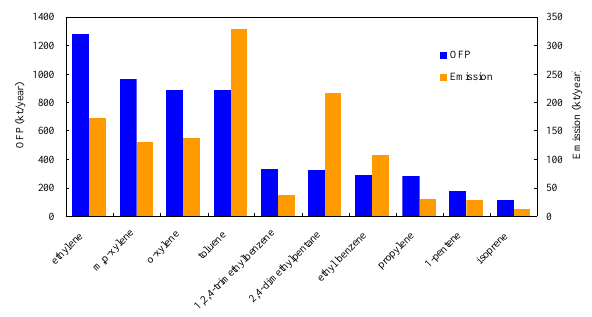
Fig. 5. The most important 10 VOC species of OFP contribution and their emissions in the YRD in 2007.